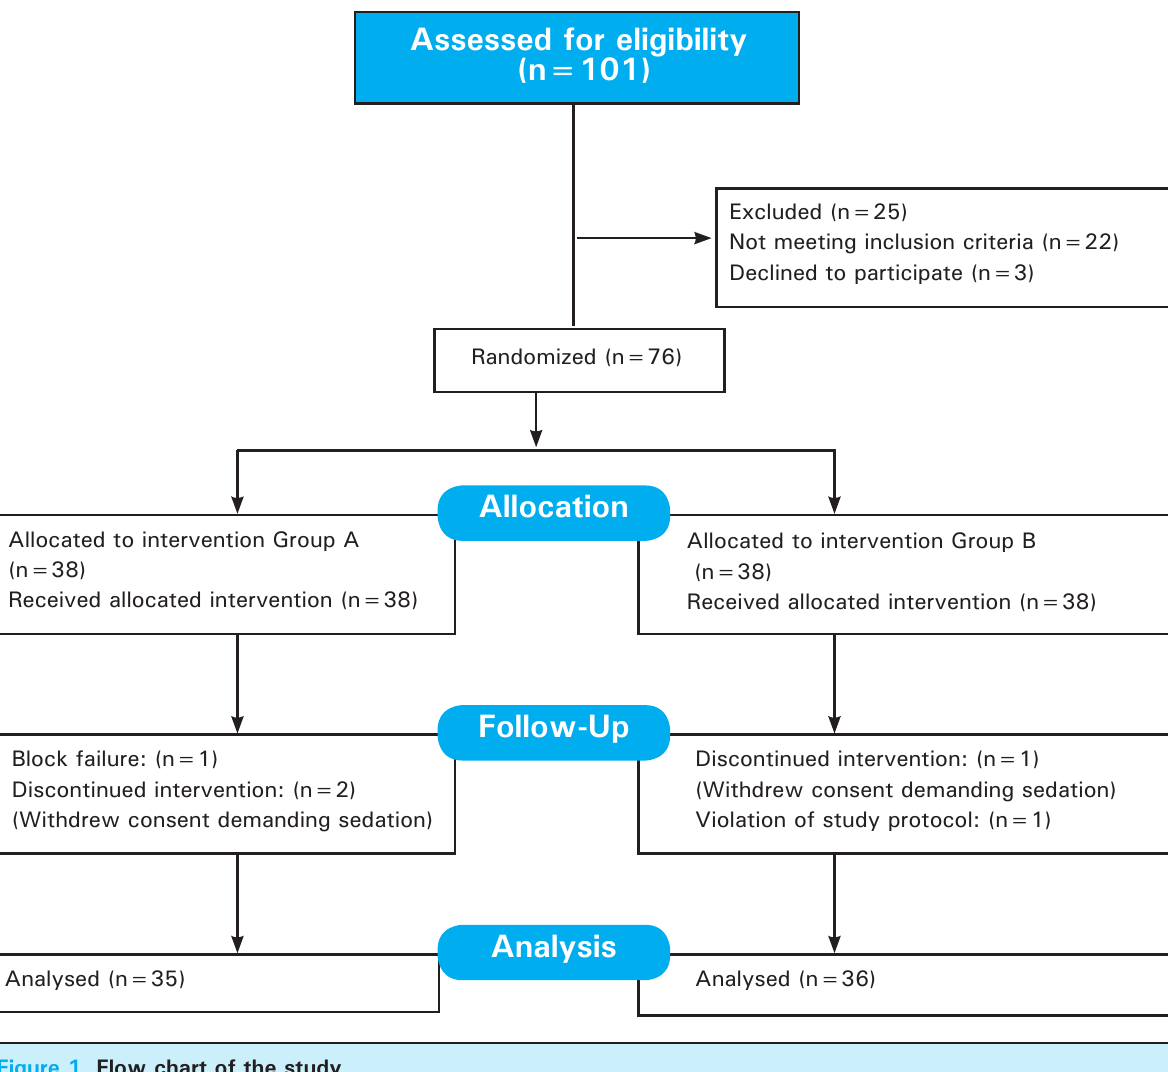
was The onset of sensory block indicated by times to reach T-10 and peak sensory blocks appeared earlier in the Group B. Peak sensory block was significantly higher and duration of sensory and motor blocks were both significantly prolonged in Group B when compared to Group A (Table 2).